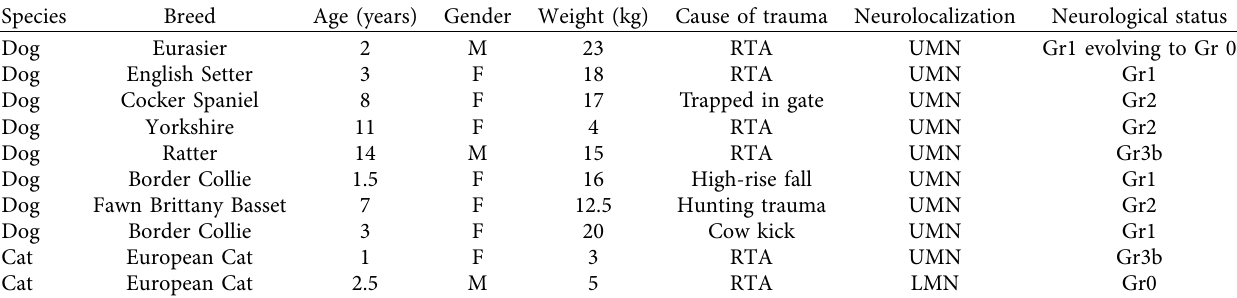
Table 1: Patient signalment, cause of trauma, and neurological status upon admission. Species